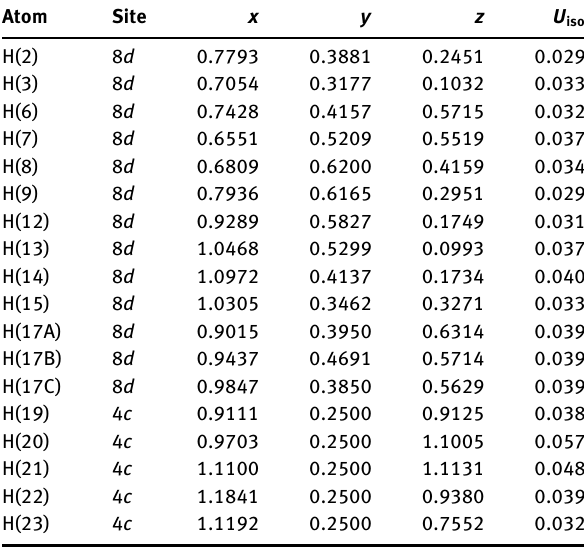
The crystal structure is shown in the figure. Tables 1–3 contain details of the measurement method and a list of the atoms including atomic coordinates and displacement